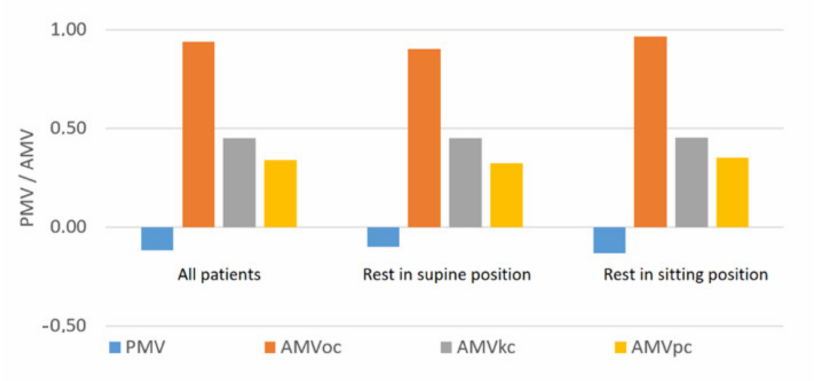
Figure 3. Predicted mean value of thermal conditions vs. actual mean value of thermal conditions for different patient